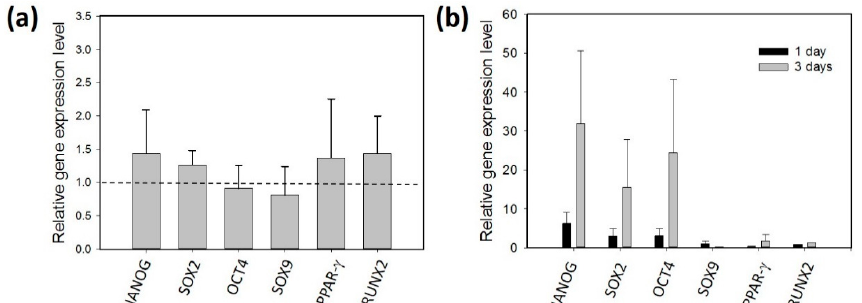
Figure 6. ( a ) Control experiment that cultured the ADSCs without mechanical stretching stimulation. The gene expression level was compared before and after a three-day culture course. ( b ) Investigation of the gene expression of the ADSCs after the stimulation of the multi-axial tensile strain. The ADSCs were respectively stimulated by the multi-axial tensile strain for one day and three days. The ADSCs were isolated from the tissue samples of patients #1 and #2. The data were generated from three repeated experiments for each tissue sample. The data are presented as mean ± standard error.